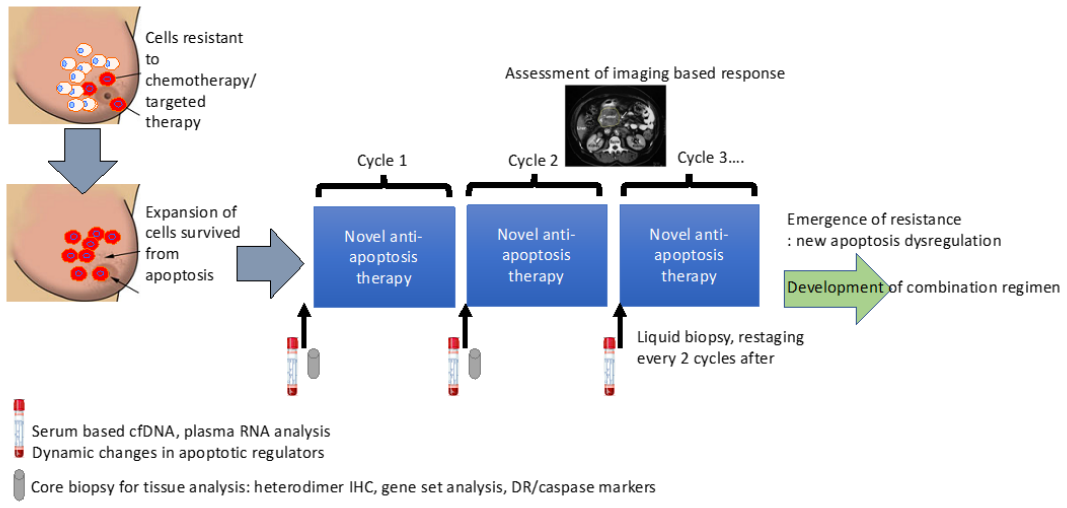
Figure 4. Proposed strategy to translate the anti-apoptosis therapeutics.